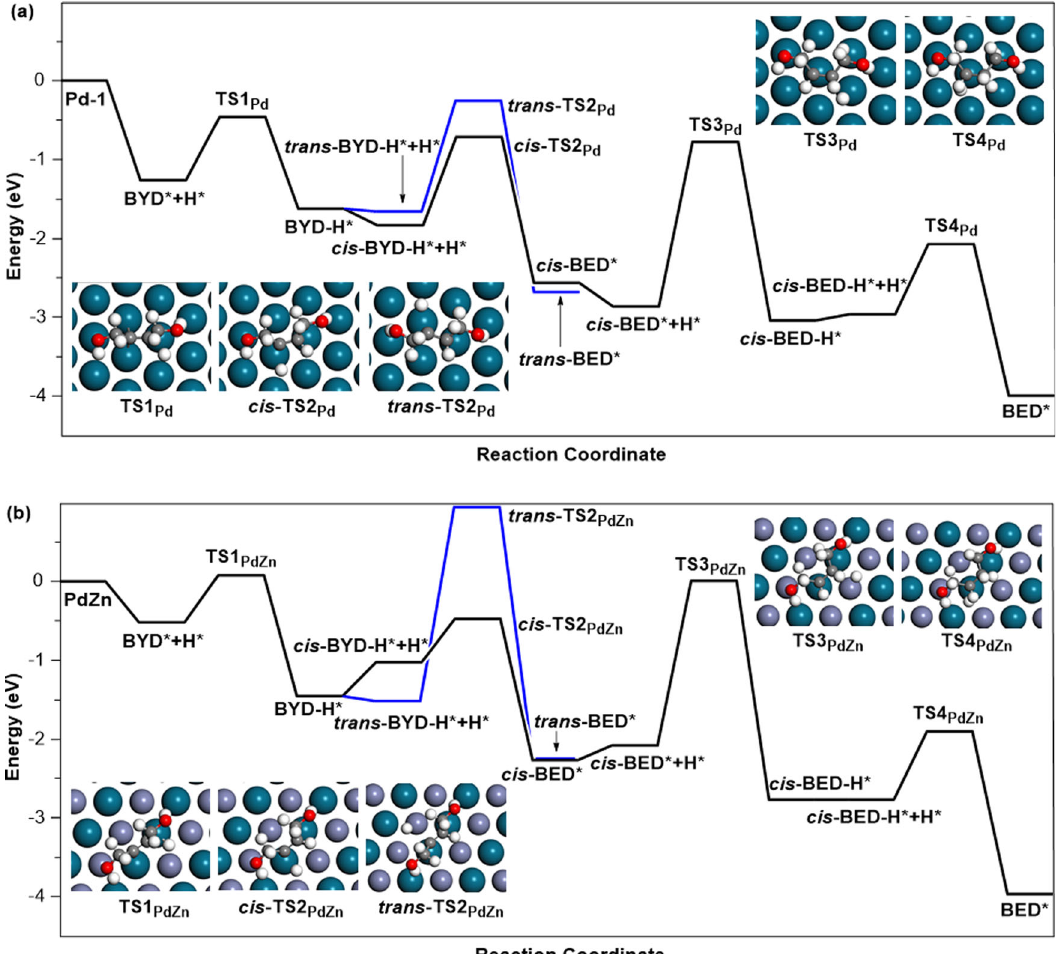
Fig. 5 Transition states of BYD hydrogenation. Potential energy diagram by theoretical calculation for the hydrogenation of C ≡ C bonds in BYD over a Pd (111) and b PdZn (111).